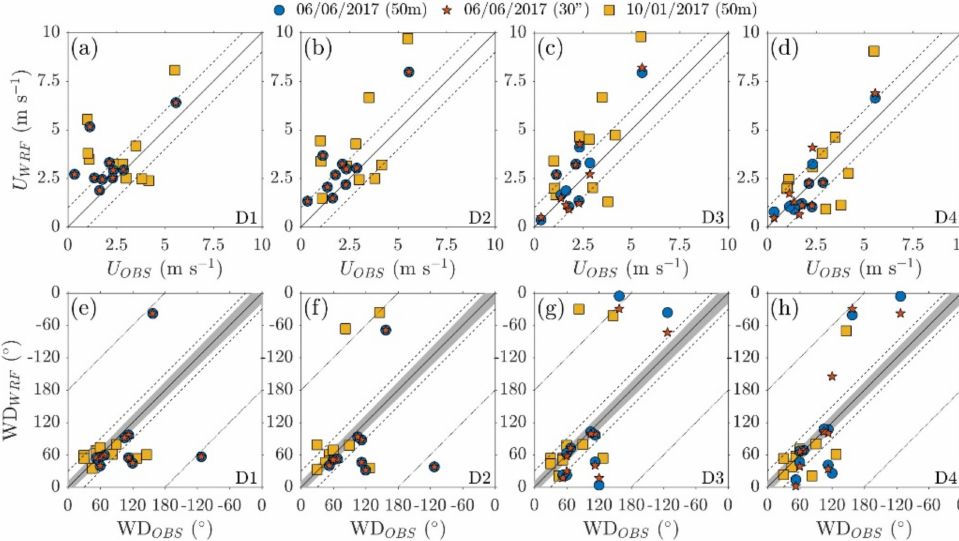
Figure 11. Scatter plots of WRF output against surface observations for horizontal wind speed (first row) and direction (second row) for: ( a , e ) D1, ( b , f ) D2, ( c , g ) D3, and ( d , h ) D4 for the three different simulations. Values shown are 3–h averages (0700–0900 JST). In the first row, the black diagonal line denotes a 1–1 match and the dashed lines denote a ± 1 m s –1 difference. In the second row, the black diagonal line denotes a 1–1 match, the gray shaded area shows the observation error ( ± 11.25 ◦ ), while the dashed and dotted lines denote a ± 30 ◦ and ± 180 ◦ difference,